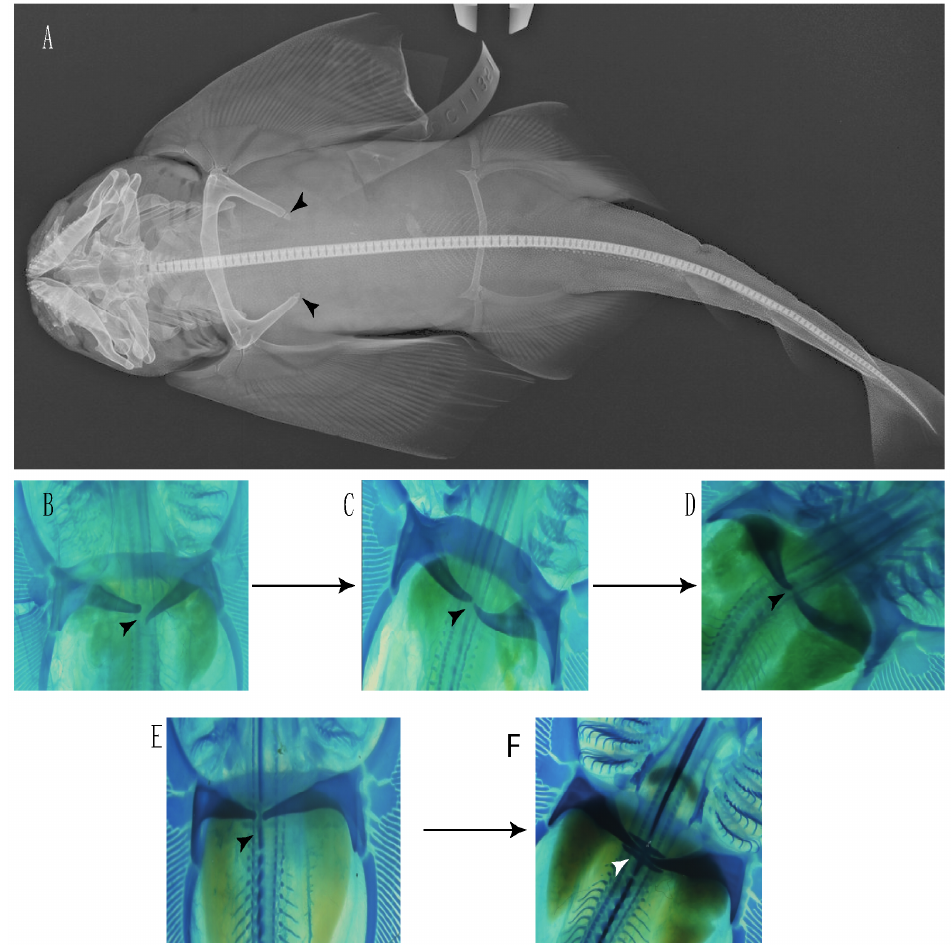
Figure 29. Dorsal view of the scapular region. State (0): ( A ) X-ray of a juvenile of Squatina dumeril [104] photo by Sandra J. Raredon. State (1): ( B – F ) Developmental stages of Zapteryx brevirostris (UREJ Unpublished data). Arrowheads: suprascapula cartilages.